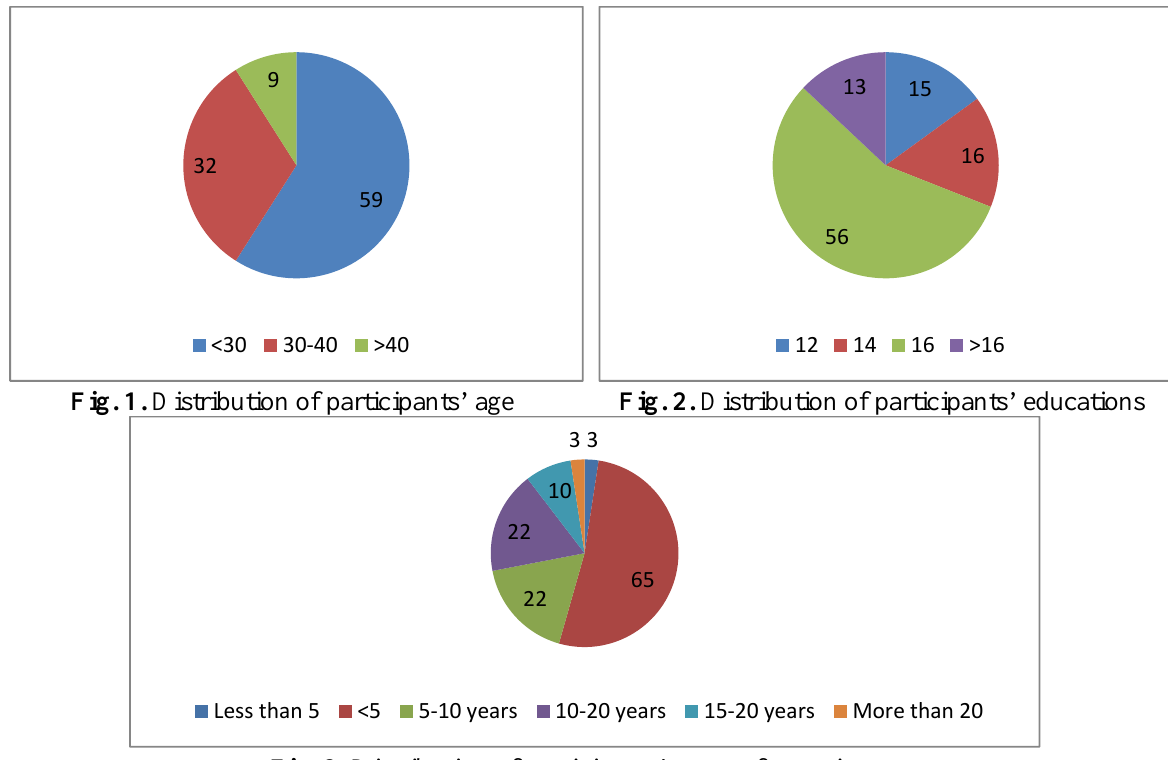
Fig. 3. Distribution of participants’ years of